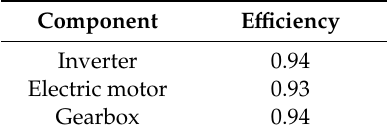
Table 2. Drivetrain component e ffi